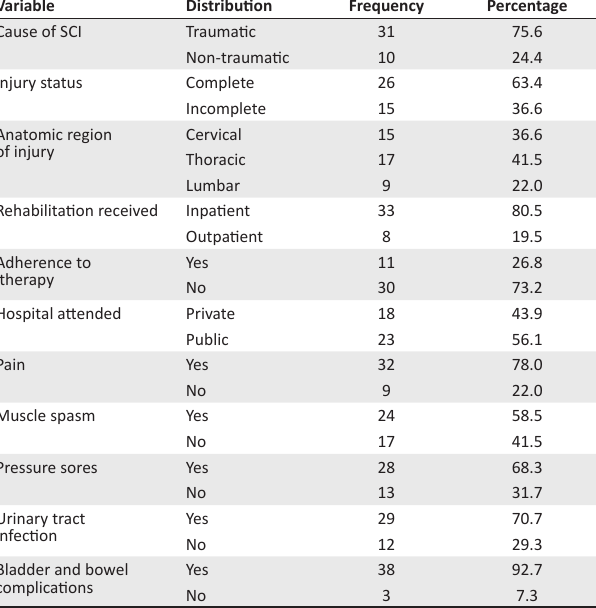
TABLE 4: Association between aetiology, type of injury, rehabilitation and secondary complications and Reintegration to Normal Living Index visual analogue scale % ( n =